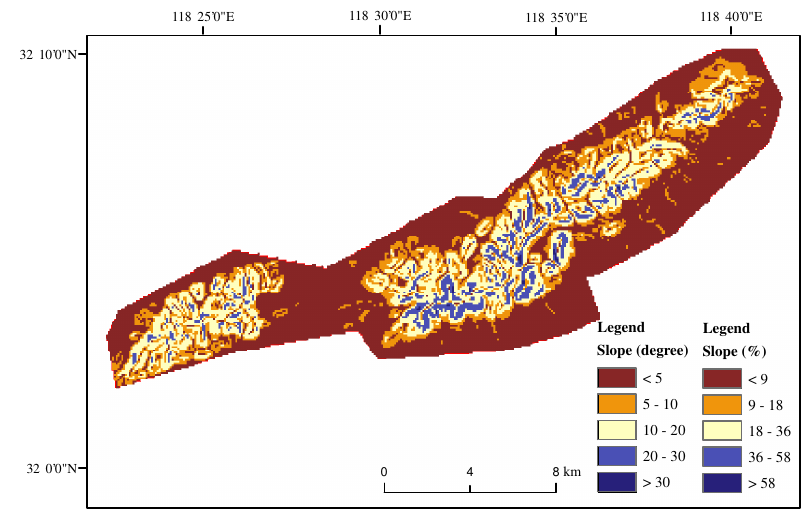
Figure 4. The base map of slope in Laoshan. Each level is determined by the fire risk classification.